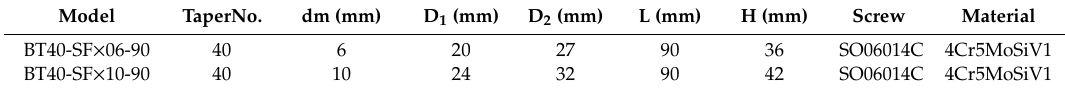
Figure 2. BT40-SF shrink-fit tool holder ( a ) physical photo; ( b ) structure diagram. Table 1. The parameters of the shrink-fit tool holder.